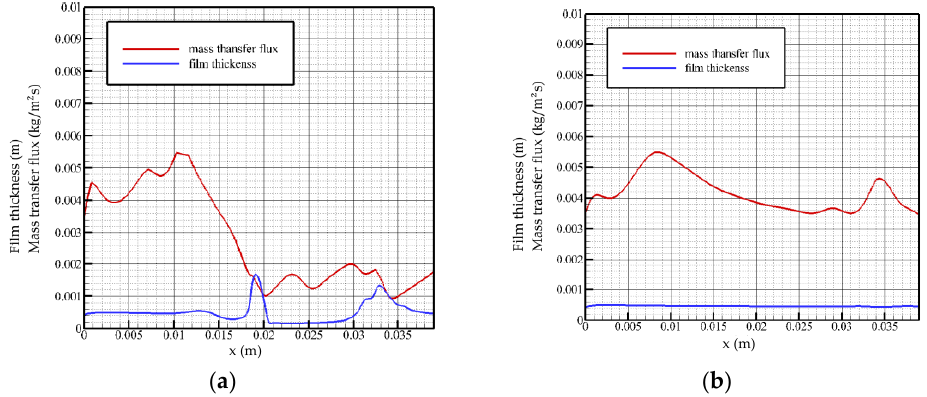
Figure 5. Mass transfer flux and liquid film surface height as a function of flow distance, Re = 20. ( a ) t = 0.58 t 0 , ( b ) t = 2 t 0 .